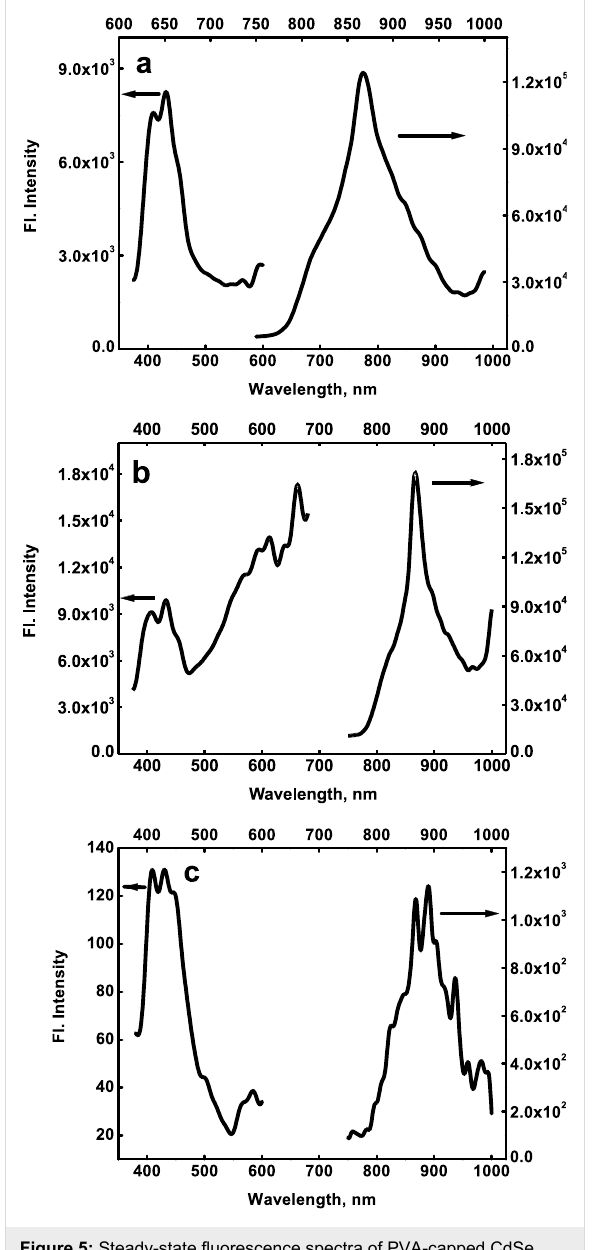
Figure 5: Steady-state fluorescence spectra of PVA-capped CdSe quantum dots, synthesized by the reaction of (a) 2 × 10 − 3 mol dm − 3 Cd(AcO) 2 with 1 × 10 − 3 mol dm − 3 Na 2 SeSO 3 , (b) 4 × 10 − 3 mol dm − 3 Cd(AcO) 2 with 1 × 10 − 3 mol dm − 3 Na 2 SeSO 3 , and (c) 2 × 10 − 3 mol dm − 3 Cd(AcO) 2 with 4 × 10 − 3 mol dm − 3 Na 2 SeSO 3 , in the presence of 9.2% PVA, at 27